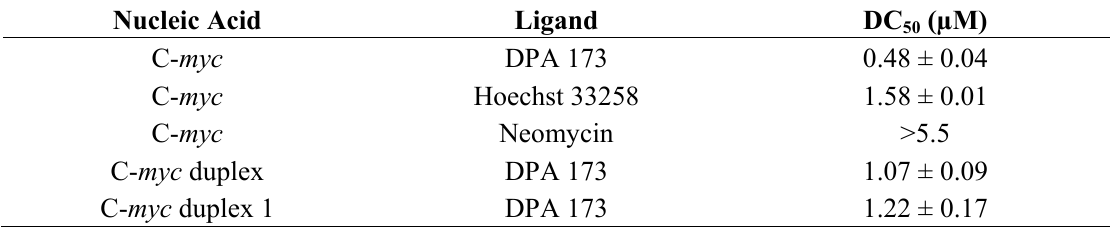
values obtained by titration of various nucleic acids using DPA Table 2. DC 50